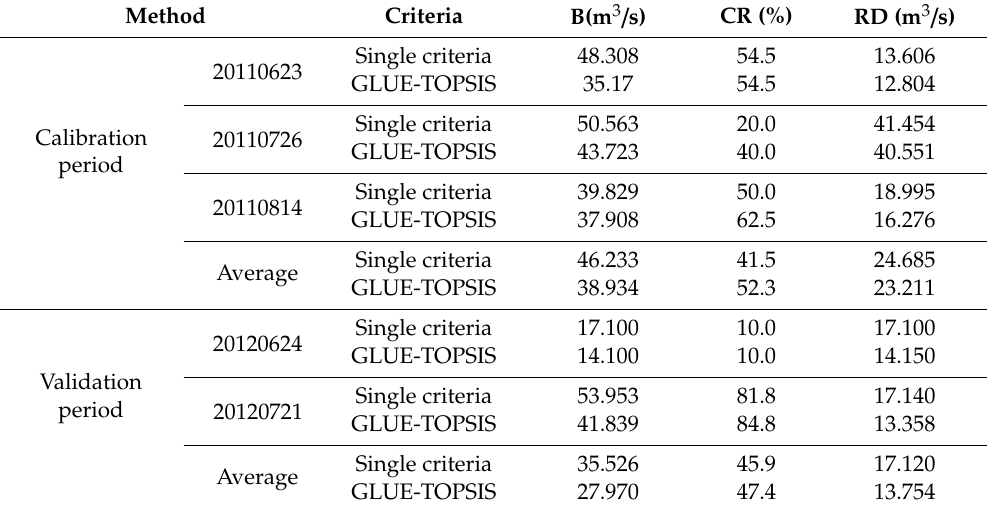
Table 3. Uncertainty interval evaluation results.